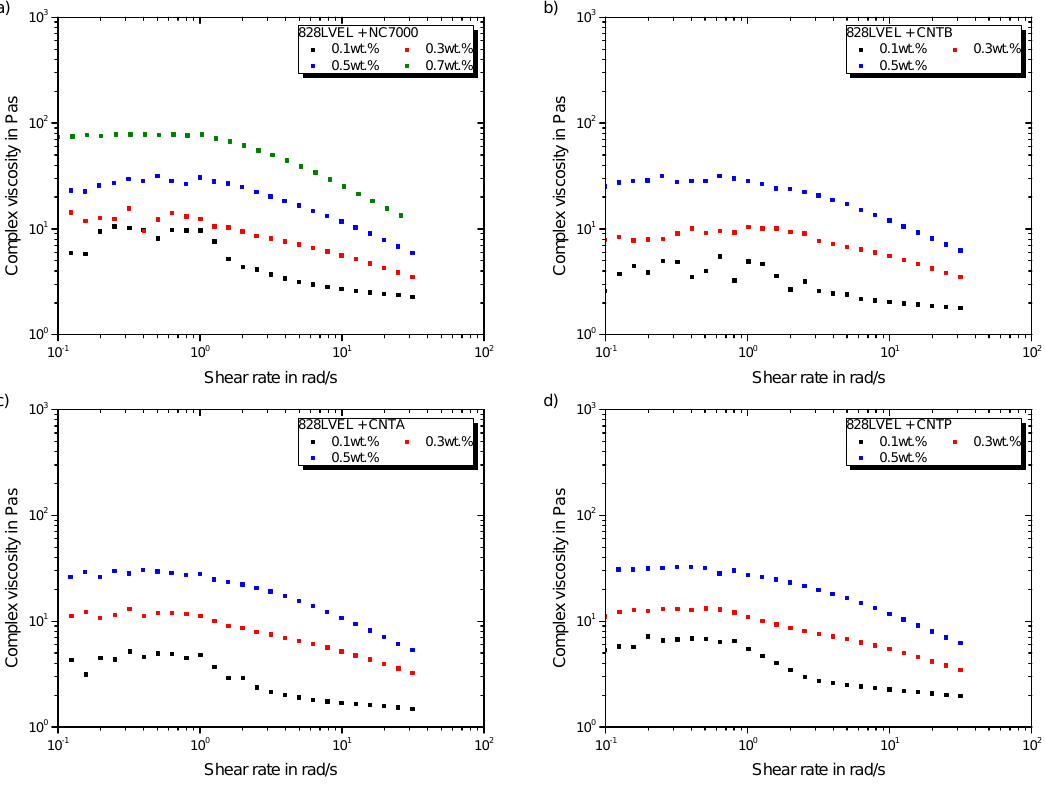
Figure 5. Rheological behavior of MWCNT modified 828LVEL and RIMH137/134 ( a ) NC7000 ( b ) CNTB ( c ) CNTA ( d )